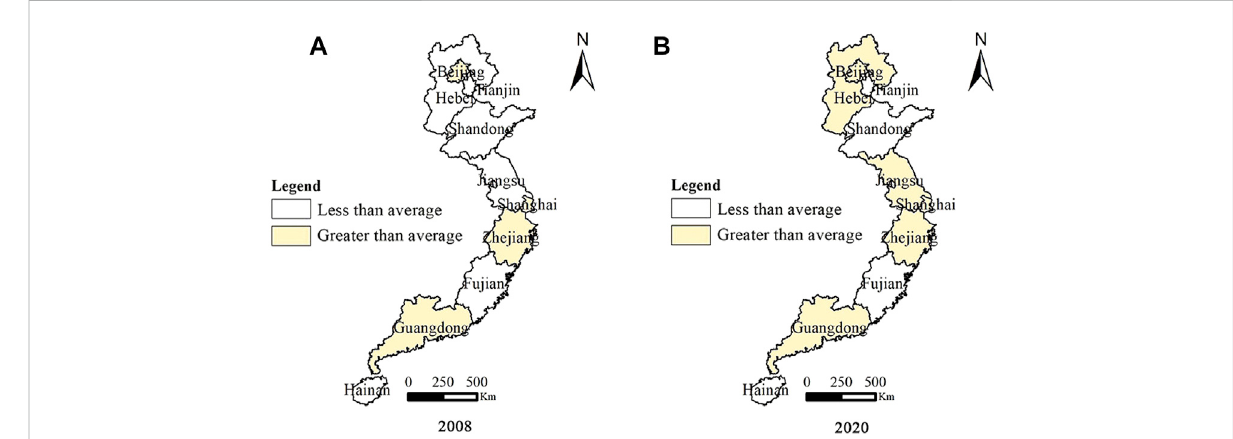
FIGURE 6 Spatial differentiation of development conditions support dimension (2008 and 2020).